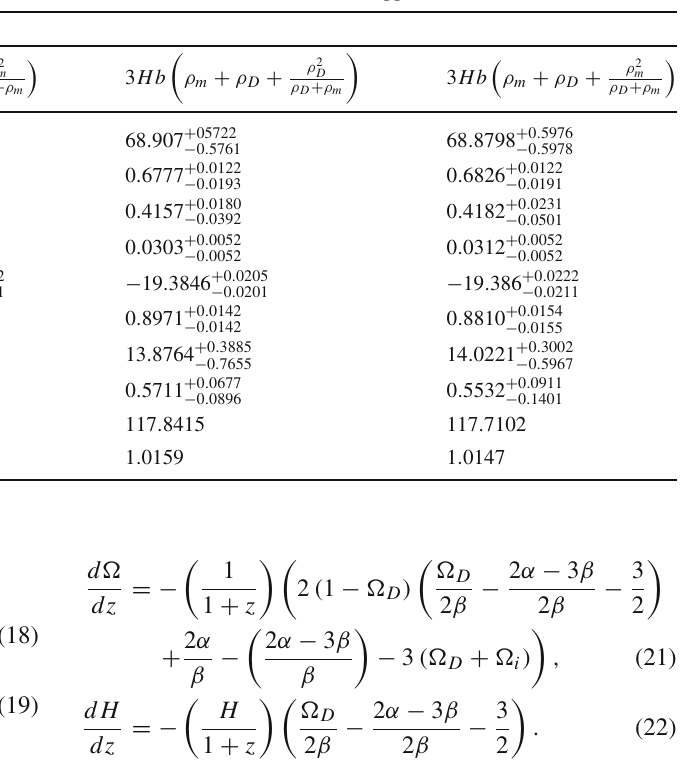
Table 3 The fitted values of cosmological parameters for the holo- graphic Ricci dark energy model (Eqs. (15) and (16)) using non-linear interactions listed in Table 1. The Pantheon supernova data, BAO ters (GC) data has been used (see Appendix